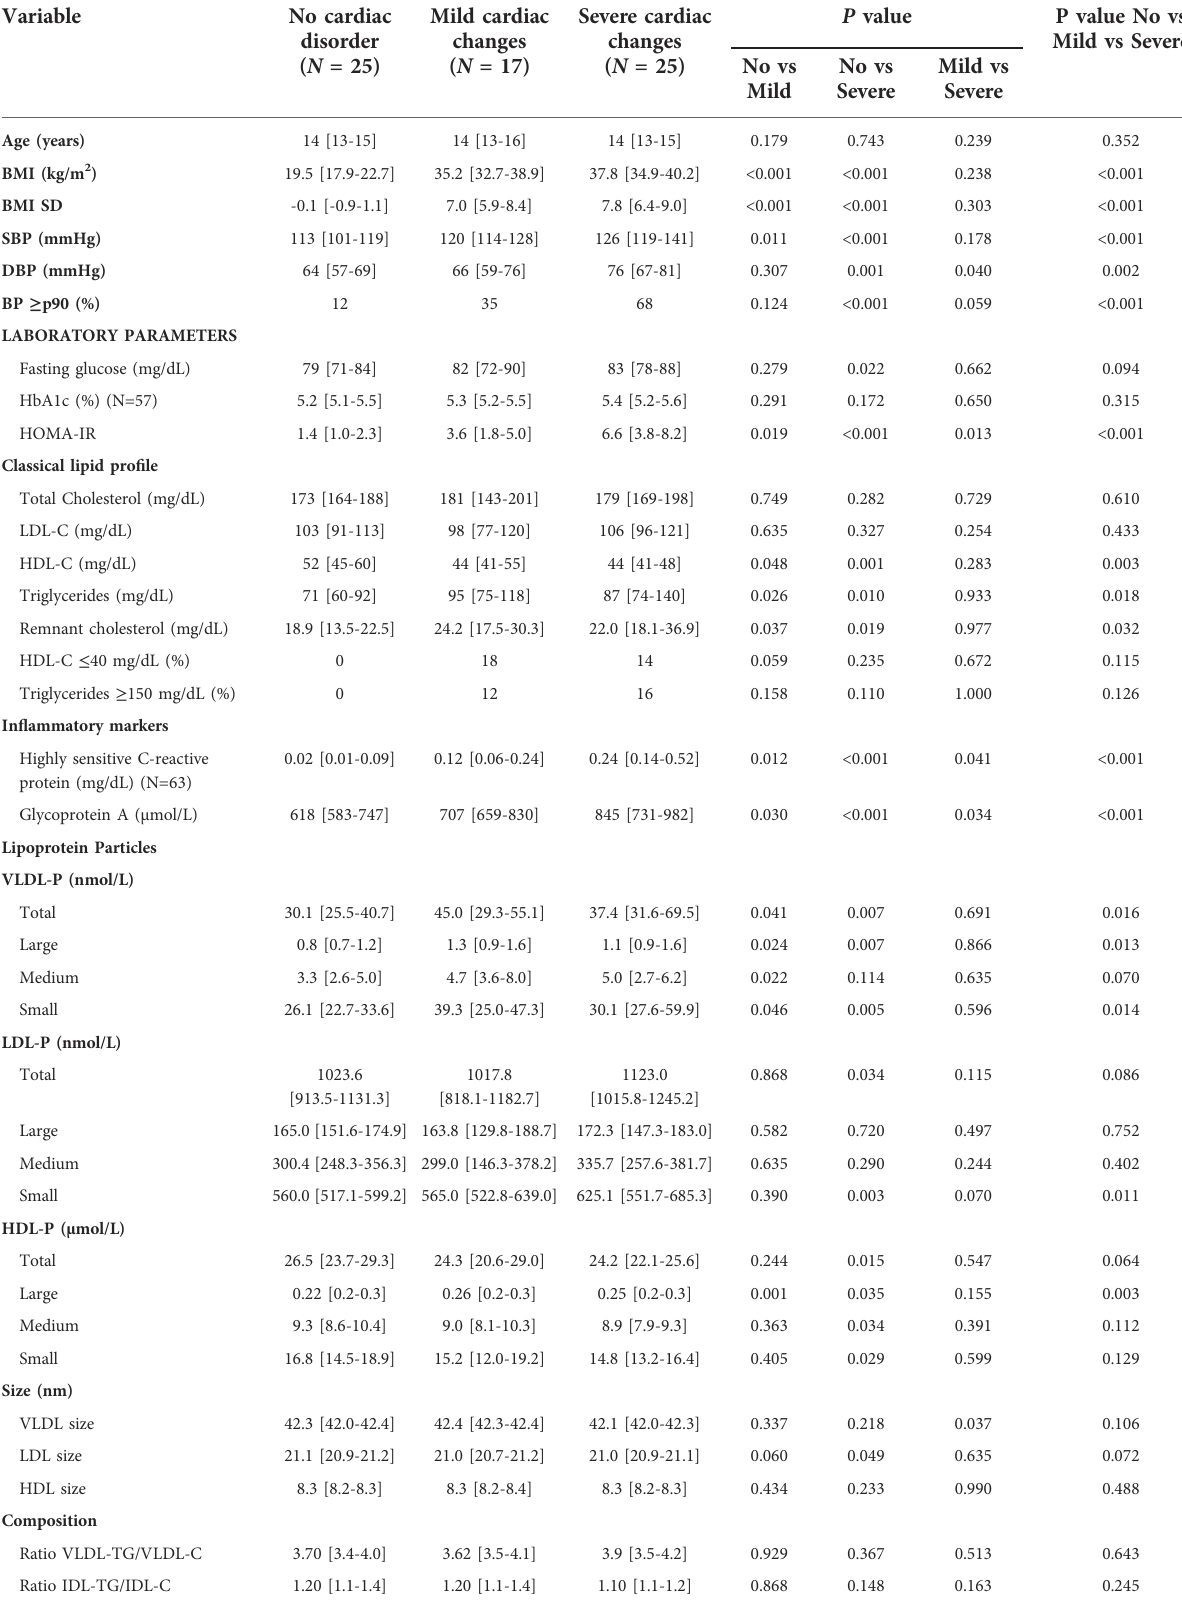
TABLE 1 Clinical and laboratory characteristics of subjects depending on cardiac involvement degree groups.